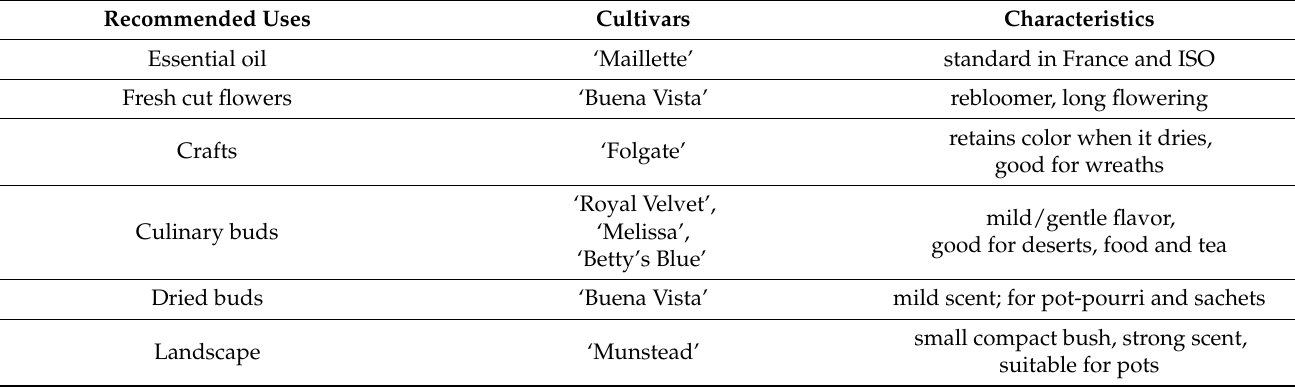
Table 2. Some L. angustifolia cultivars suitable for different uses